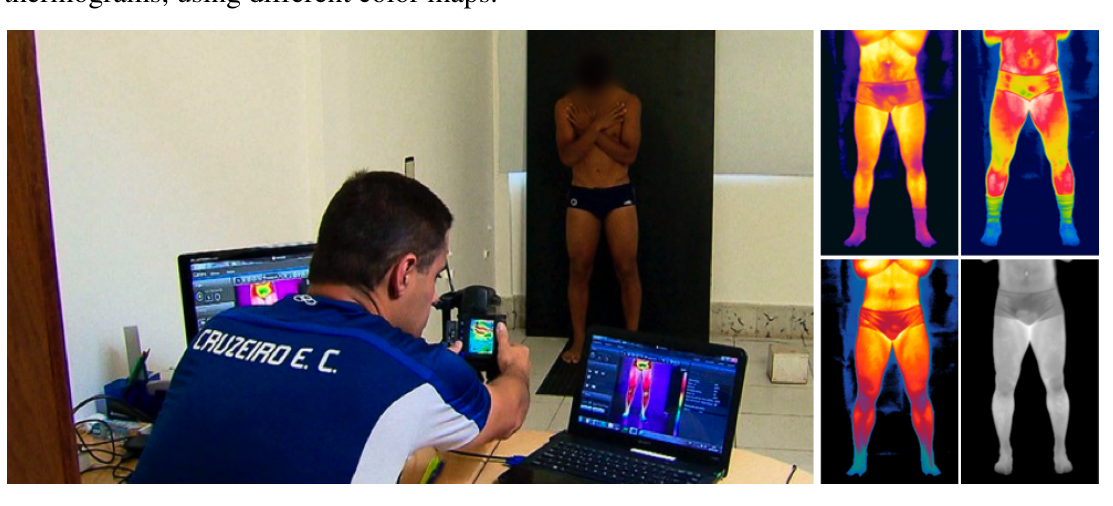
Figure 3. ( Left ) The thermal imaging acquisition protocol; ( Right ) Examples of players’ thermograms, using different color